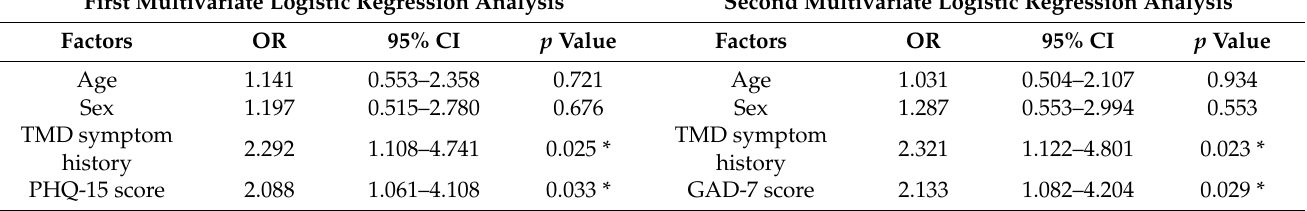
Table 8. Double multivariate logistic regression analysis to estimate the PHQ-15 score and GAD-7 score associated with the condylar bony